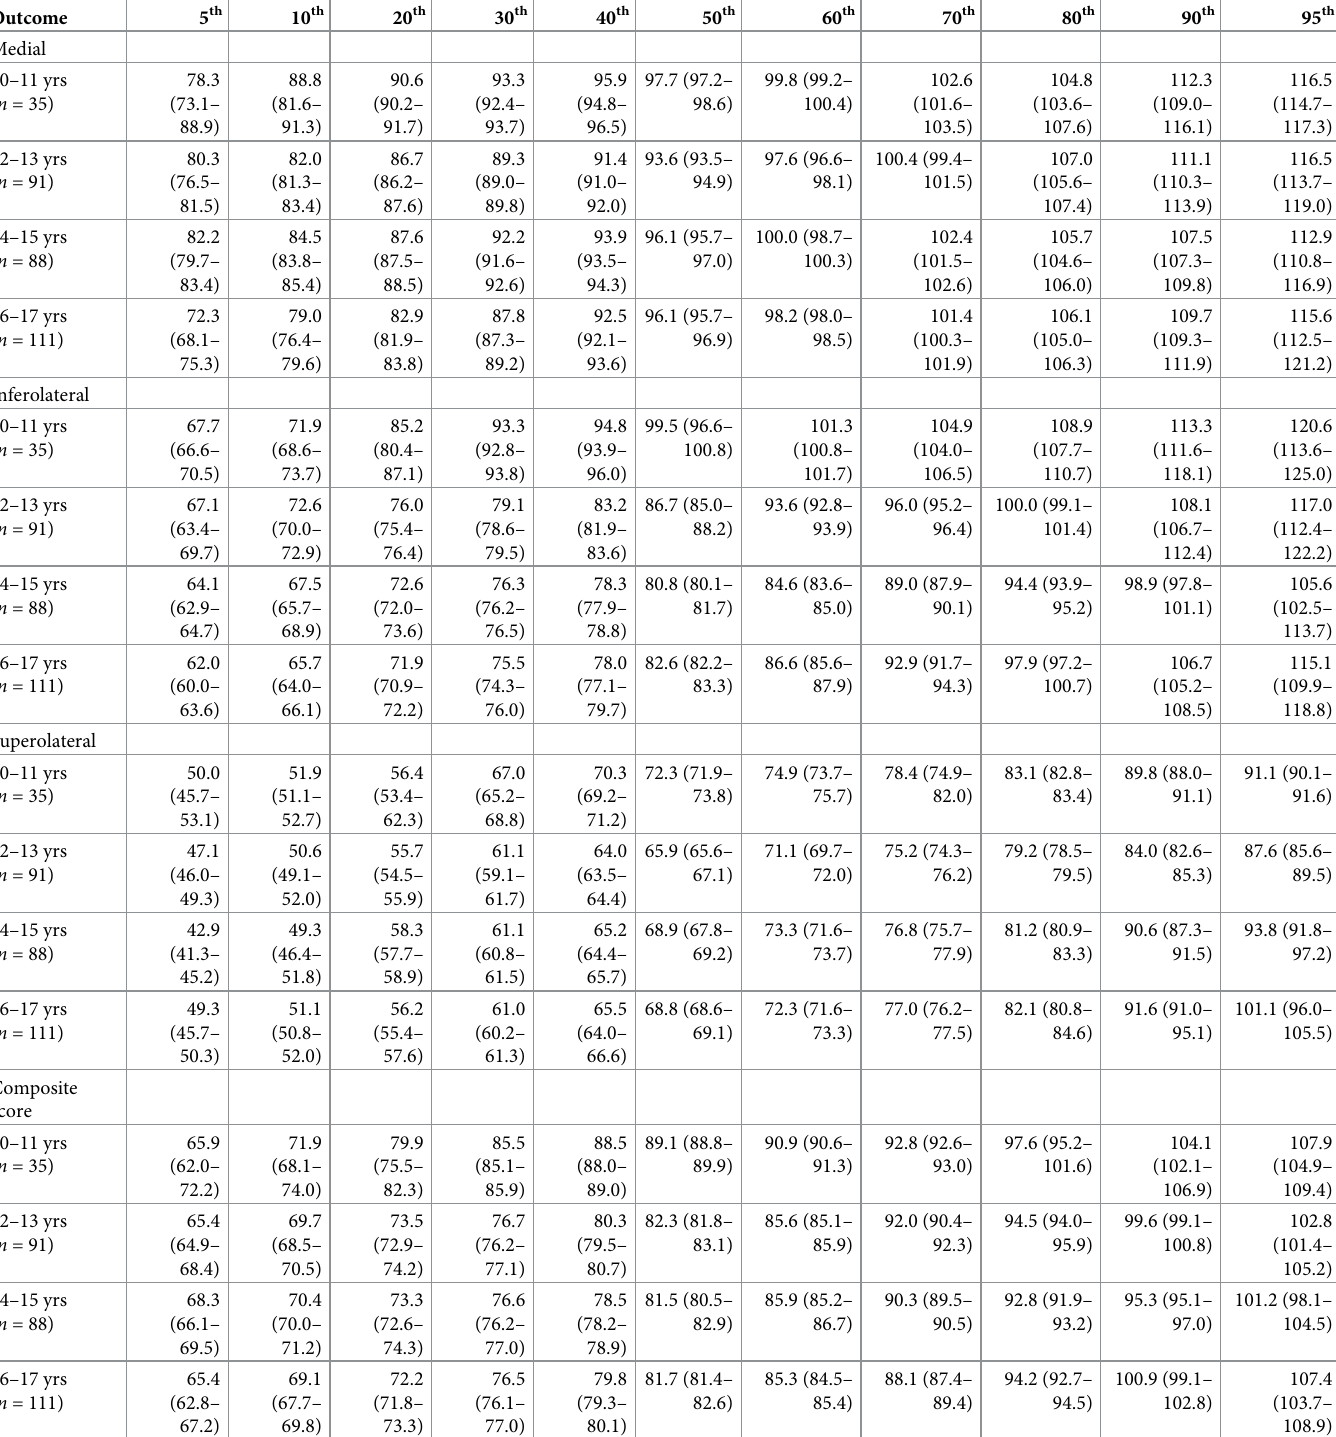
Table 6. Smoothed age-specific percentile values with 95% confidence interval for the normalized (% arm length) maximal left arm reach distances and the compos- ite score in females ( n = 325) aged 10 to 17